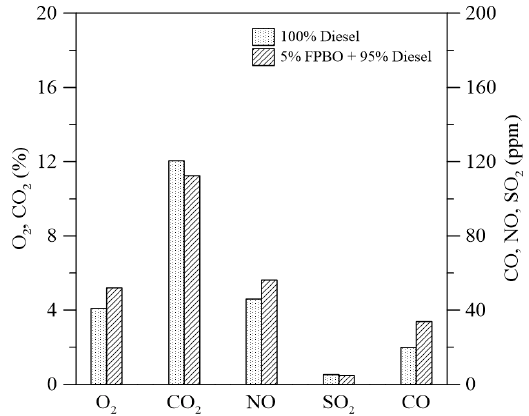
Figure 8. Average emissions when burning diesel alone and the blend of 5% FPBO + 95% diesel.